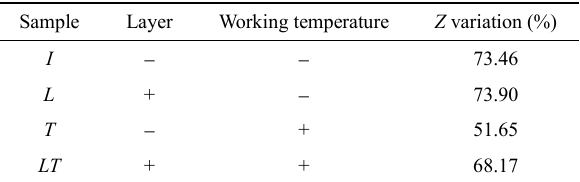
Table 2 Impedance modulus variation of the TiO 2 /WO 3 structures as response to the combination of studied L and T parameters. The symbols (-) and (+) represent the lowest and highest values of the parameters, respectively Sample Layer Working